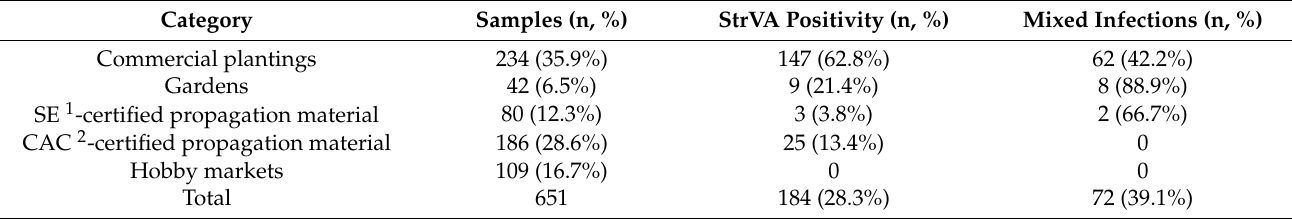
Table 1. StrVA findings in strawberry samples.